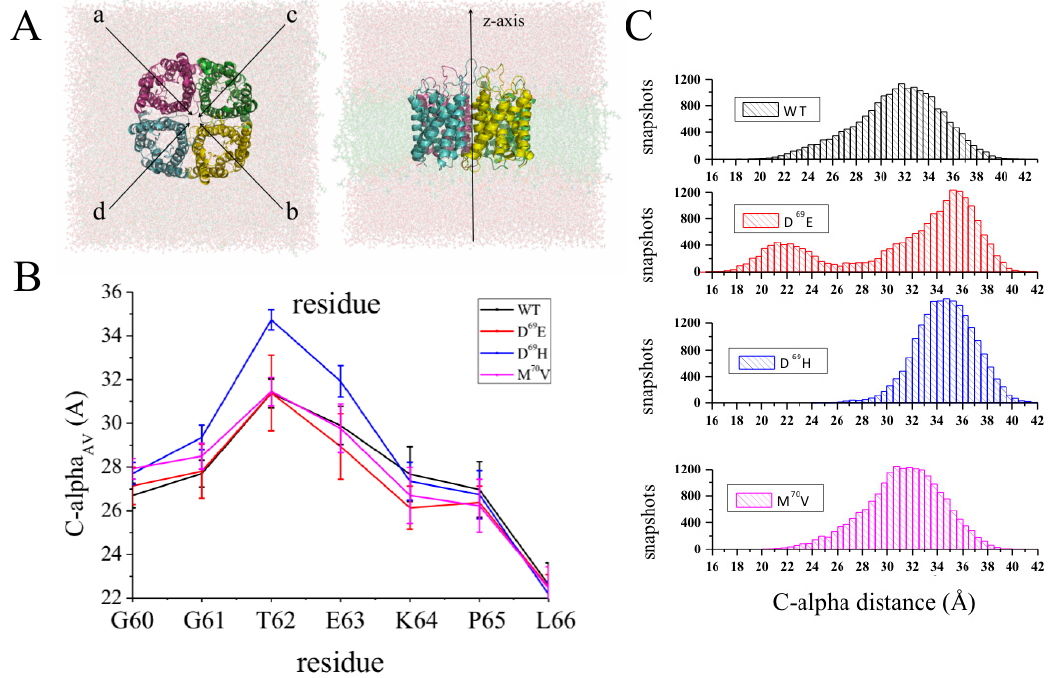
Figure 6. Conformational “domino effect” resulting from D69E and D69H mutations. ( A ) Top ( left ) and lateral ( right ) view of the investigated system; ( B ) C-alpha AV values computed for residues belonging to a portion of the loop A (from residue G60 to residue L66); ( C ) Distance distribution function of C-alpha distances computed for residue T62. The uncertainties related to C-alpha distances are computed by the block averaging method [97]. Adapted after permission from reference [96].